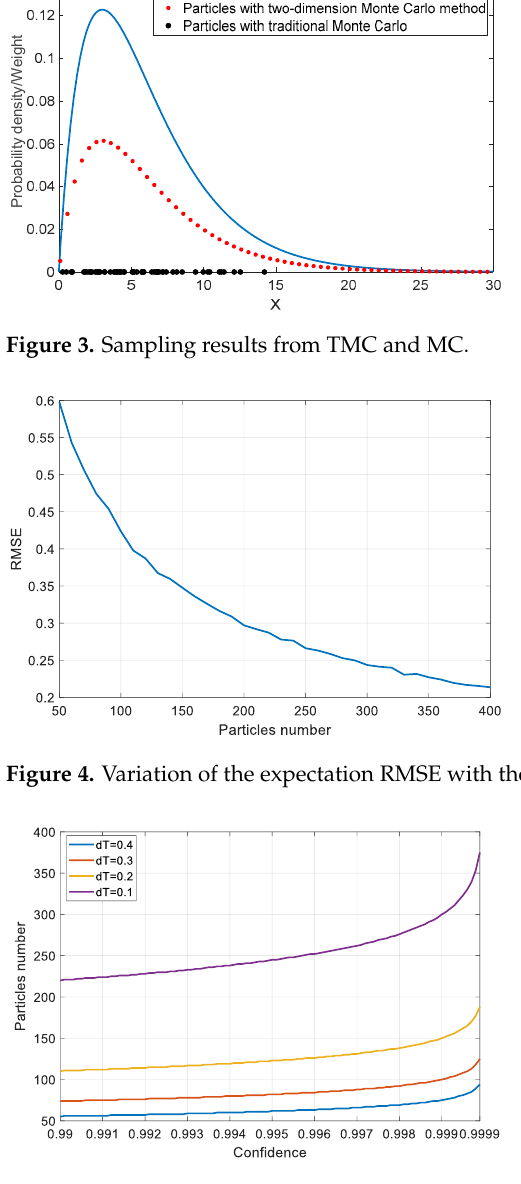
Figure 5. Variation of the particle number with confidence for TMC.